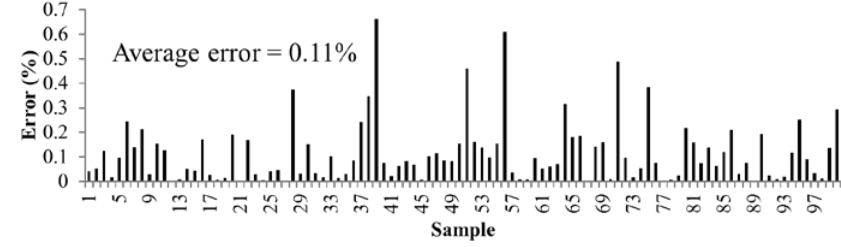
Figure 13. Errors of crack change ratio between the fixed image and calibrated images.